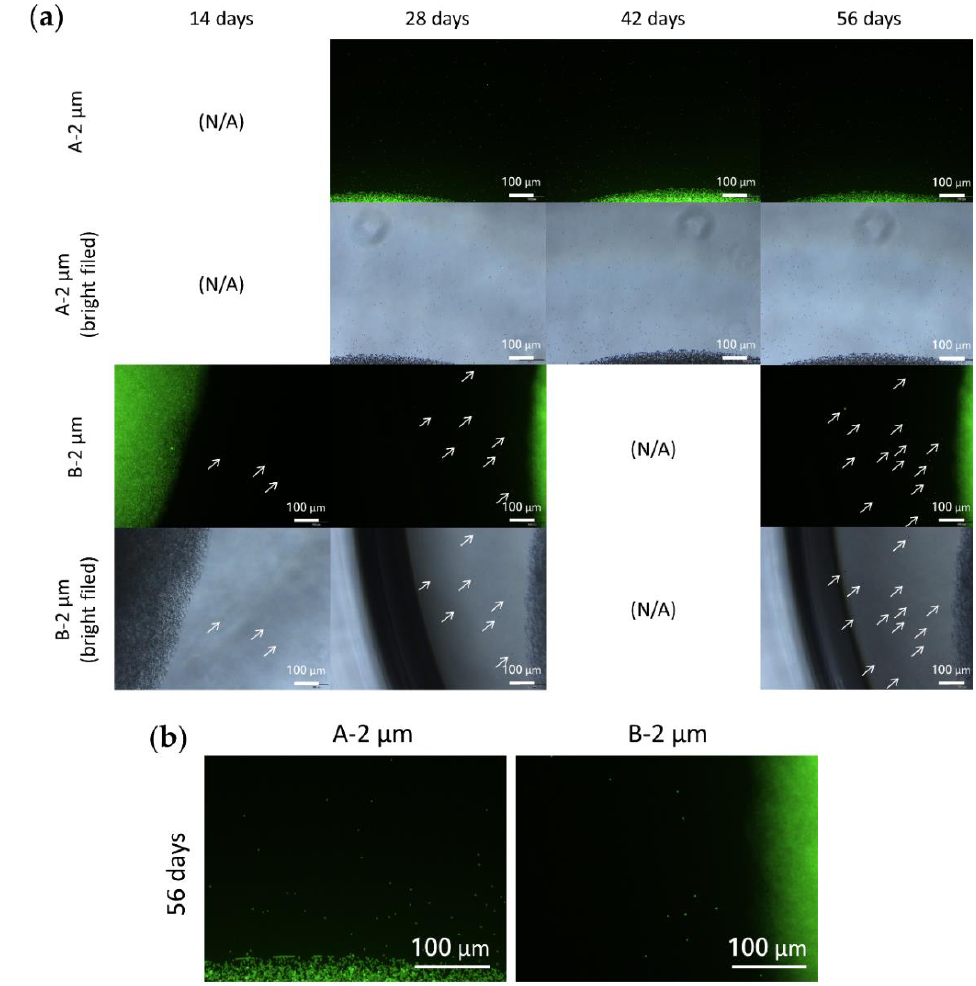
Figure 8. ( a ) Distribution of 2 µ m PS fluorescent microparticles in the hydrogel with polymer concentrations of 1.5% and 3%. White arrows indicate the microparticles released from the hydrogel. ( b ) Enlargements of the two groups after 56 days incubation, clearly showing that PS MPs were more easily released from groups with lower hydrogel polymer concentration. This finding corresponded to the groups loaded with PS NPs.